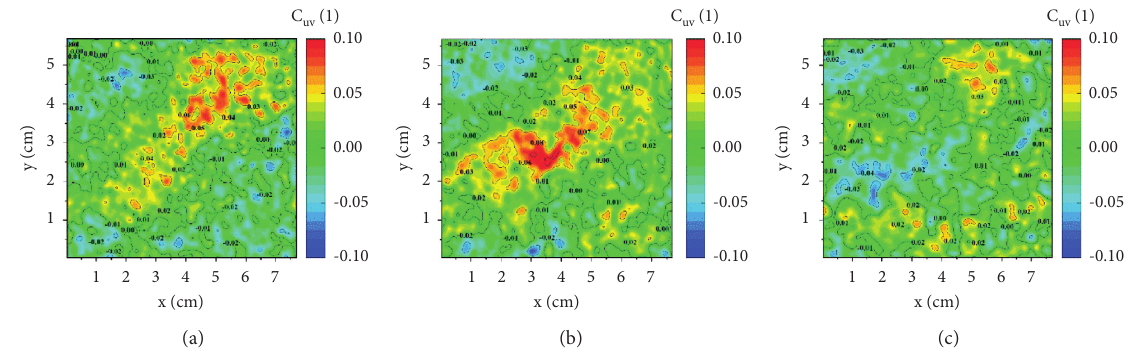
Figure 9: The distribution of C uv in different working conditions. (a) B25S. (b) B25M. (c) B25L.